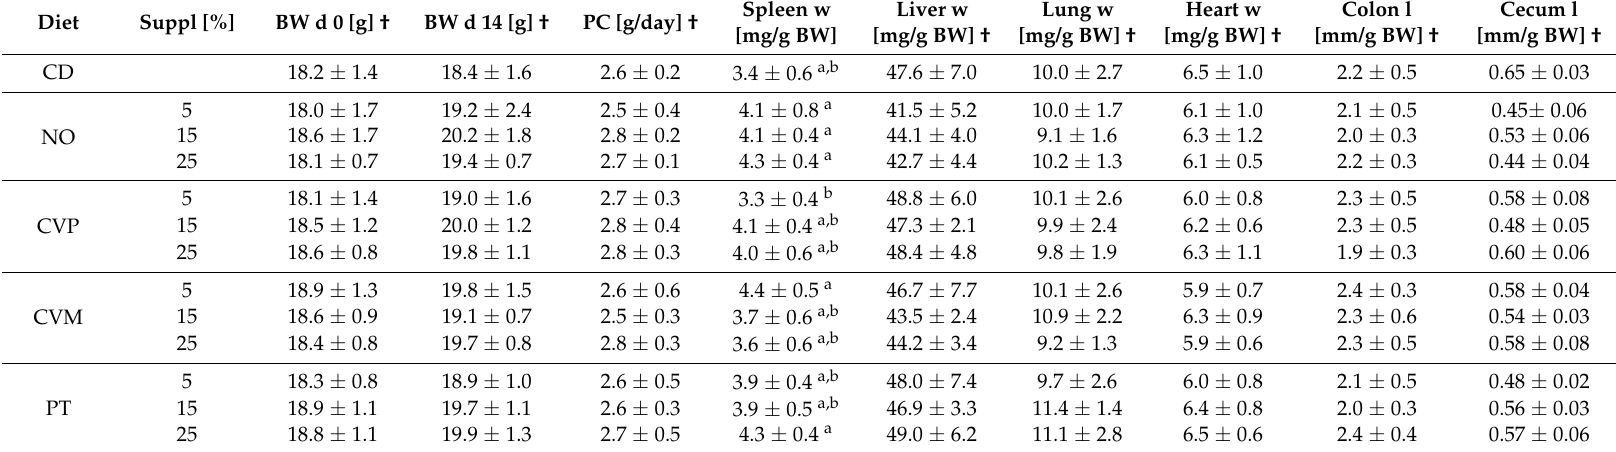
Table 2. Body weight of C57BL/6J mice before and after 14 days diet consumption and organ parameters after the 14 days. Data are expressed as mean ± SD ( n =